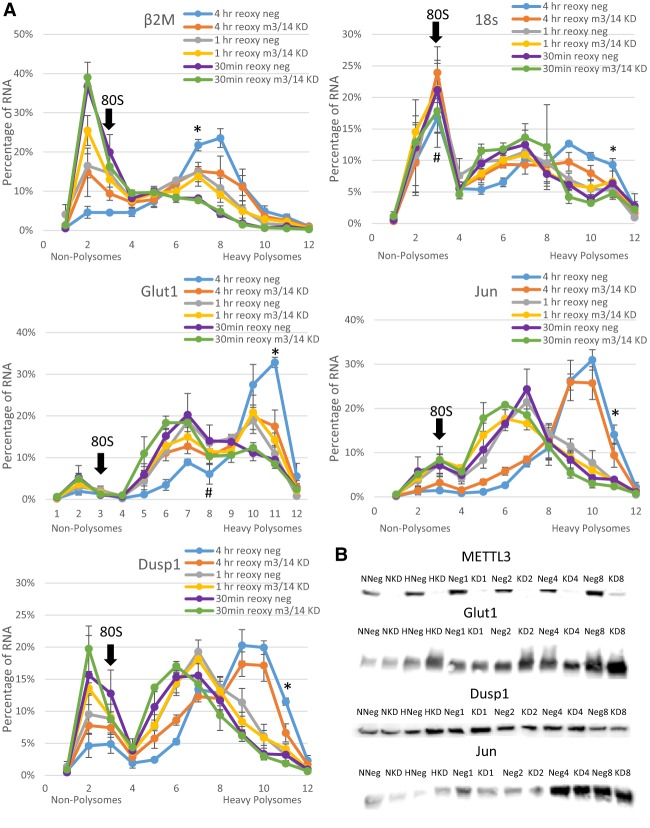
METTL3/14 Knockdown decreased the ability of messages to recover from hypoxic stress after 4 h reoxygenation. (A) HEK-293T cells harvested after 72 h transfection with METTL3/14 siRNA (M3/14 KD) or negative control siRNA (neg) and 24 h of hypoxic conditions and either 30 min, 1, or 4 h of room level reoxygenation recovery (reoxy). Polysome profiling of extracts separated by differential centrifugation through sucrose gradients. qRT-PCR analysis of the fractions shows percentage of individual mRNA in each fraction. Error bars represent SEM of three experiments in the 1 and 4 h reoxygenation experiments and SEM of two experiments in the 30 min reoxygenation experiment. Fraction containing the 80S peak is marked. Paired Student's t-test indicates significant (P ≤ 0.05) decrease (*) or increase (#) compared to negative control siRNA. (B) Western blots of 50 µg of protein lysates of normoxic negative control siRNA (NNeg), normoxic METTL3/14 Knockdown (NKD), hypoxic negative control (HNeg), hypoxic METTL3/14 Knockdown (HKD), and 1, 2, 4, or 8 h reoxygenation after hypoxia (representative of three experiments).